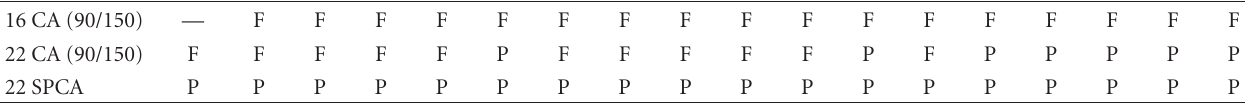
Table 4: Diehard results for hybrid CA and SPCA optimized for throughput.